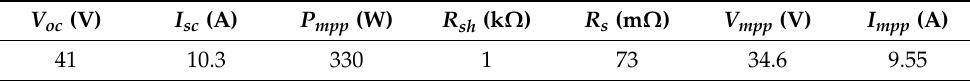
Table 1. GPV under investigation specifications.